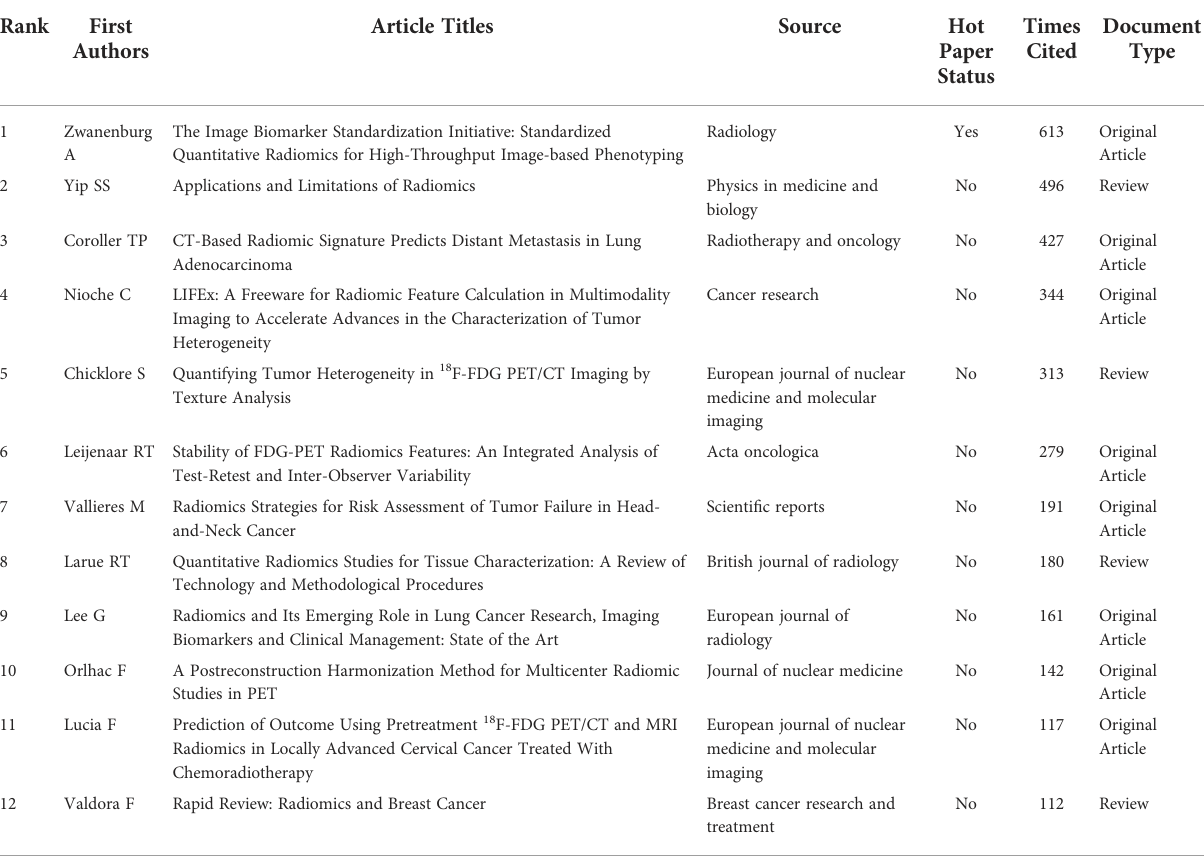
TABLE 2 Top 12 highly cited papers in 18 F-FDG PET/CT radiomics research from WoSCC.